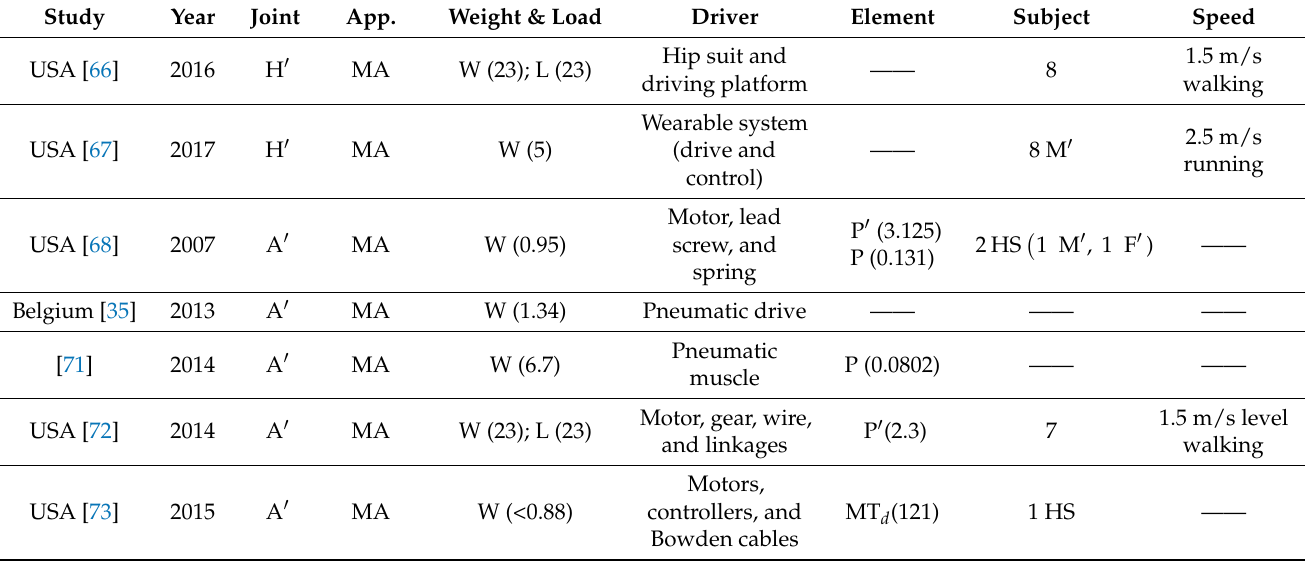
Table 3. Powered lower limb single-joint assisted